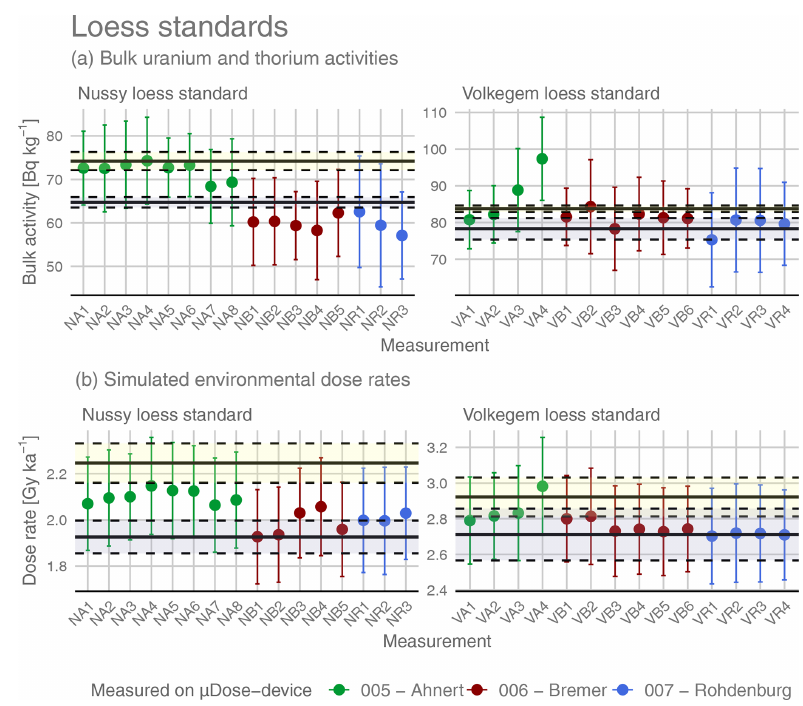
Figure 4. Bulk uranium and thorium activities given in becquerels per kilogram (Bqkg − 1 ) (a) and simulated environmental dose rates given in grays per thousand years (Gyka − 1 ) (b) for both investigated loess standards. The Nussy loess standard is depicted on the left, the Volkegem loess standard is shown on the right. The different colours of the symbols represent three different measurement devices (see legend). Please note that the bold reference lines centred within the grey area indicate radionuclide contents originally published for the Nussy loess standard by Preusser and Kasper (2001) and for the Volkegem loess standard by De Corte et al. (2007), whereas the bold lines centred within the yellow area represent benchmark values derived from the results published by Murray et al.